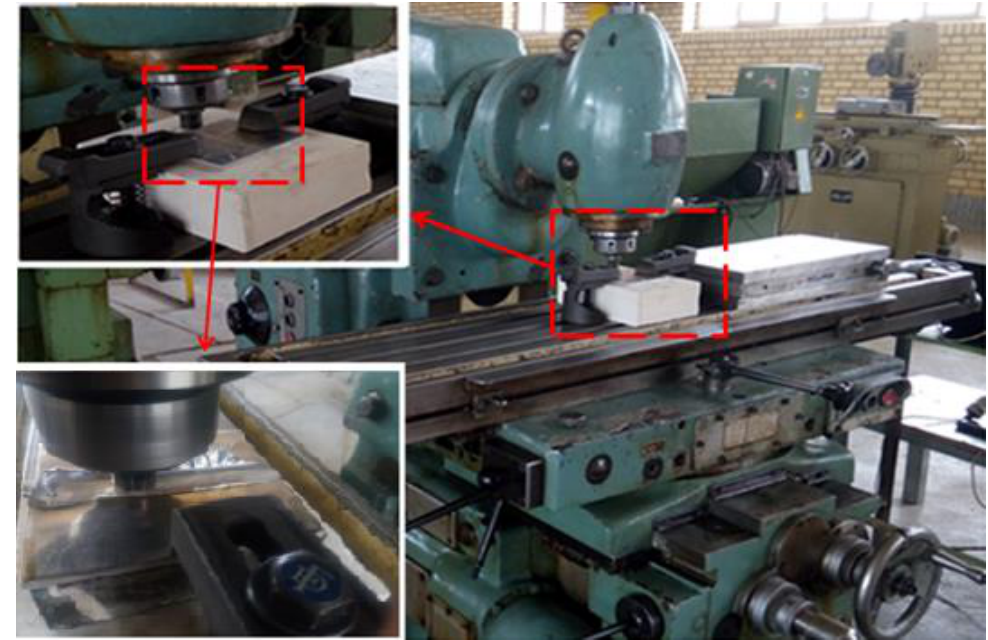
Figure 2. Schematic of milling machine and workpiece.